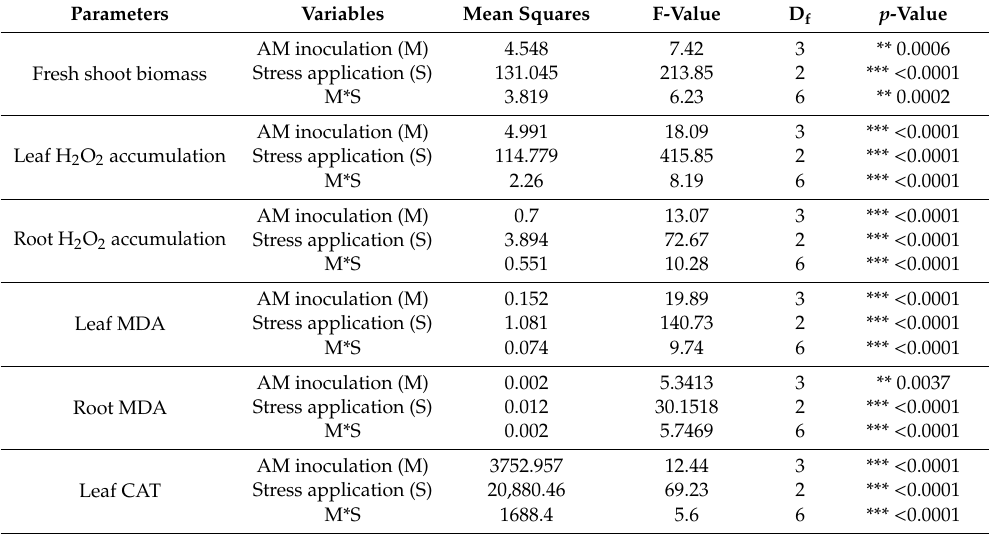
Table 1. E ff ects of arbuscular mycorrhizal (AM) inoculation (M), stress application (S), and the interaction between M and S on the measured parameters. POD, peroxidase; CAT, catalase;